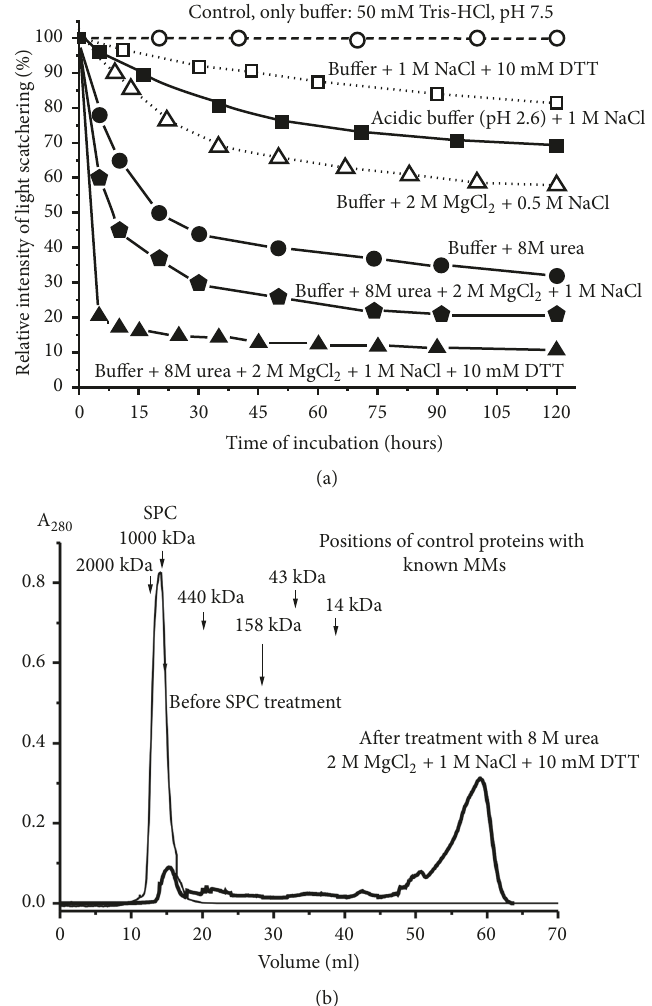
Figure 3: Typical examples of the time courses in changes of the relative light scattering (LS) intensity of the SPC mix (0.5 mg/mL; mixture of the complexes from nine milk preparations) in different conditions (a). The relative maximal light scattering at the experiment zero time was taken for 100 %. Gel filtration on a Superdex 200 of the SPC mix after its incubation for 120 h in buffer containing 8 M urea +2 M MgCl 2 + 1 M NaCl and 10 mM DTT: (—) absorbance at 280 nm (A 280 ) (b). For details, see Materials and